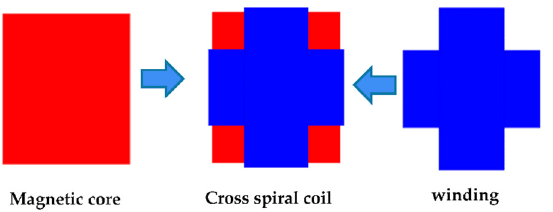
Figure 5. Schematic diagram of the cross-coupled coil structure.